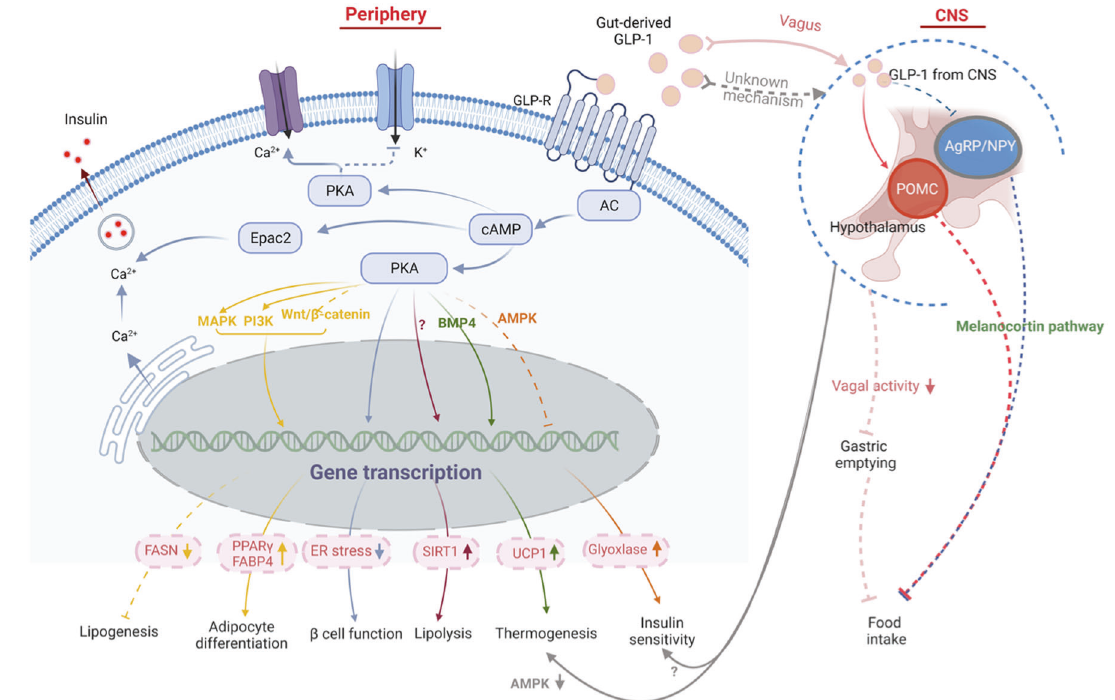
Fig. 5 GLP-1 signaling pathway in obesity pathogenesis. The anti-obesity effect of GLP-1 can be mediated by either peripheral or central signals. In the periphery, the activation of GLP-R by gut-derived GLP-1 enhances the glucose-stimulated insulin secretion, through PKA- dependent or Epac2 pathway. By enhanced PKA activity, GLP-1 alleviates insulin resistance and leads to weight loss in obese diabetic mice by reducing ER stress and improving β -cell function. It also improves insulin sensitivity in peripheral tissue by suppressing AMPK-related pathway and elevating glyoxalase. By interacting with multiple signaling pathways including PI3K, MAPK, and Wnt4- β -catenin pathways, GLP-1 promotes pre-adipocyte differentiation by up-regulating PPAR γ and FABP4, but suppresses lipogenesis in mature adipocytes by decreasing fatty acid synthase expression. GLP-1 also enhances lipolysis in WAT by increasing the expression and activity of Sirt1, through yet unknown mechanisms. Additionally, GLP-1 participates in the regulation of thermogenesis by inhibiting BMP4-related signaling pathway and thus induces the expression of thermogenic genes like UCP1. Gut-derived GLP-1 also interacts with GLP-R expressed in vagus, through which the information is transmitted upward to the CNS, which in turns suppresses vagal activity and gastric emptying, so as to increase satiety and reduce food intake. Besides, peripheral GLP-1 plays a role in the regulation of insulin sensitivity and BAT-related thermogenesis in a CNS- dependent manner. the latter is partially mediated by suppressing AMPK signaling pathway. Central GLP-1 produced by neurons in the caudal medulla is transmitted into the hypothalamus and functions to reduce food intake by activating POMC neurons while suppressing AgRP/NPY neurons in this area